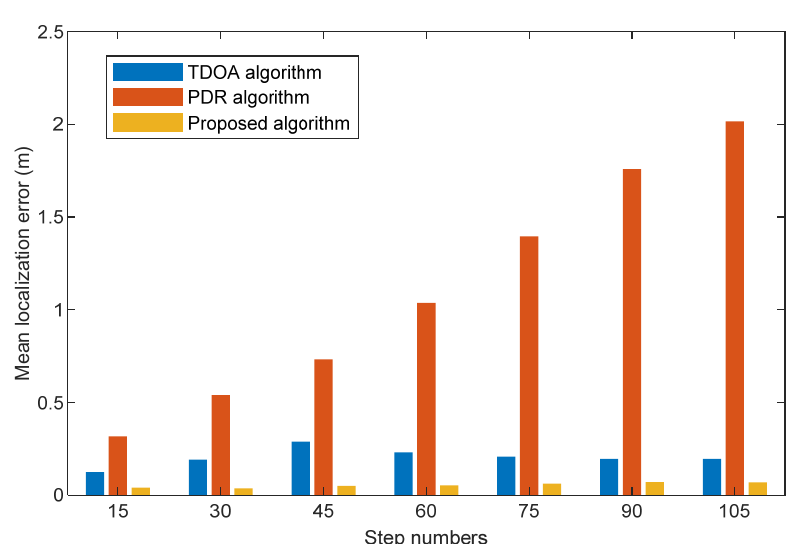
Figure 12. Localization track map with TDOA algorithm, PDR algorithm and proposed algorithm at three experimental sites. ( a ) First scene, ( b ) Second scene, ( c ) Third scene.